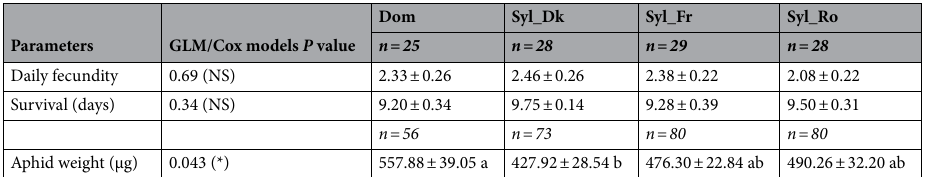
Table 2. Fitness parameters (mean ± standard error of the mean) for Dysaphis plantaginea reared on plants belonging to three Malus sylvestris populations (Danish, French and Romanian, i.e. hereafter referred as to “Syl_Dk”, “Syl_Fr”, “Syl_Ro”, respectively) and to the Malus domestica genepool (“Dom”). The letters within a row indicate significant differences associated with pairwise comparisons using estimated marginal means. * P < 0.05; ** P < 0.01; *** P < 0.001 associated with GLM models (using respectively a quasi-Poisson for daily fecundity and Gamma distribution aphid weight) or Cox models (for survival) (degree of freedom = 3 for each